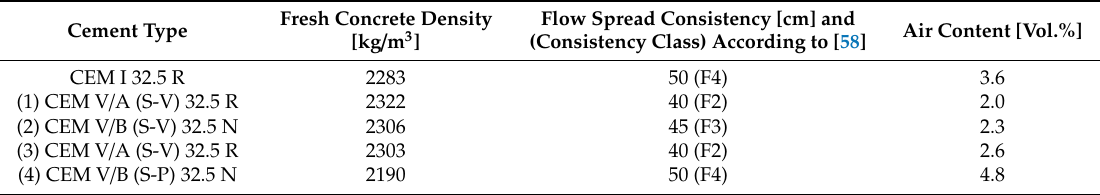
Table 6. Fresh concrete properties by using di ff erent slag-pozzolanic cement